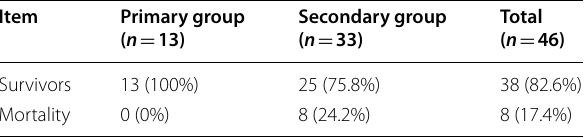
Table 8 Mortality among each group